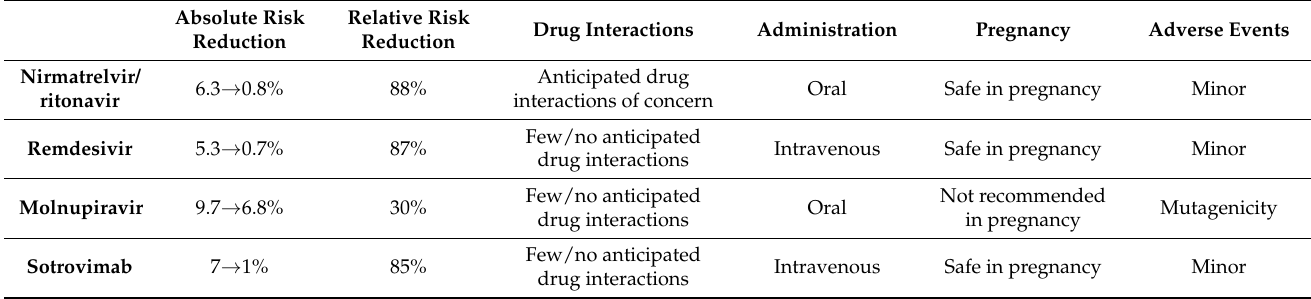
Table 1. Comparison of treatment options for high-risk non-hospitalized patients.